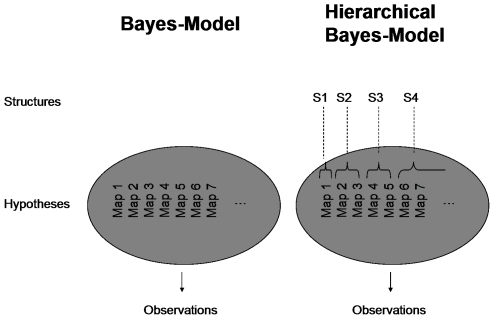
Graphical Model of the non-hierarchical and the hierarchical Bayesian model.In the non-hierarchical model the observations provide evidence for each hypothesis separately. In the hierarchical model the observations not only provide evidence for the hypotheses, but also for the different structures (which in turn might shift some evidence to structure-compatible hypotheses).